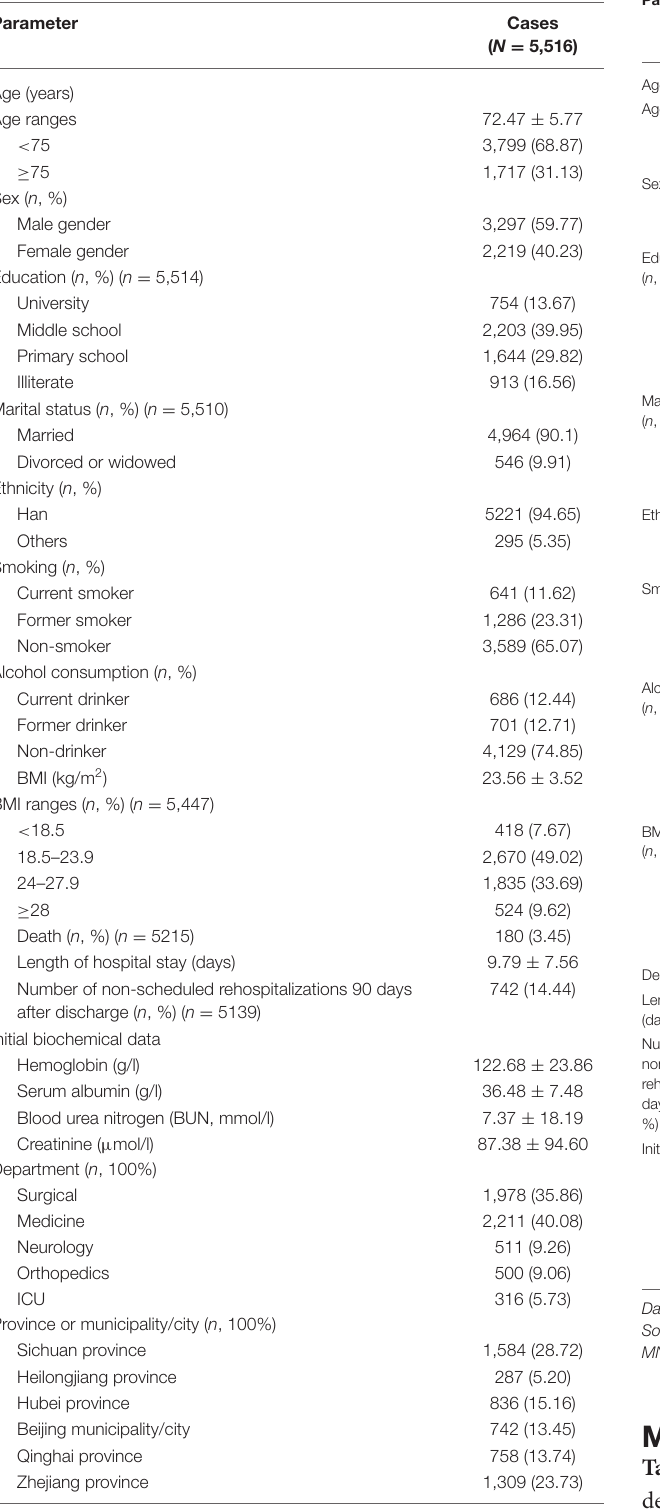
TABLE 2 | Data for hospitalizations, analyzed according to MNA-SF score. ( N = 5,516)